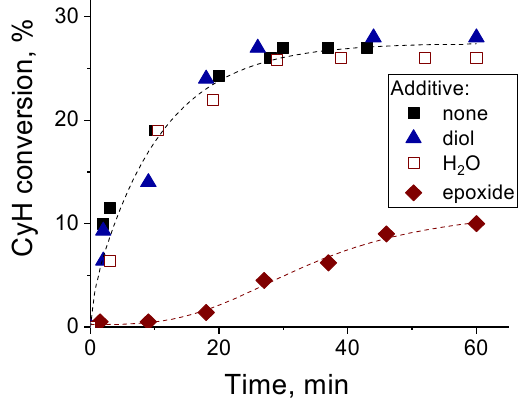
Figure 12. Effect of reaction products on CyH oxidation with H 2 O 2 over Zr-MMM-E (sample A ) and 1 equiv of HClO 4 . Reaction conditions: CyH 0.1 mmol, catalyst 10 mg (0.003 mmol Zr), H 2 O 2 (30% aq.) 0.1 mmol, HClO 4 0.003 mmol, CH 3 CN 1 mL, 50 °C. Additives: 0.02 mmol of CyH-epoxide or 0.015 mmol of CyH-diol or 0.3 mmol of H 2 O (added in the beginning of the reaction).